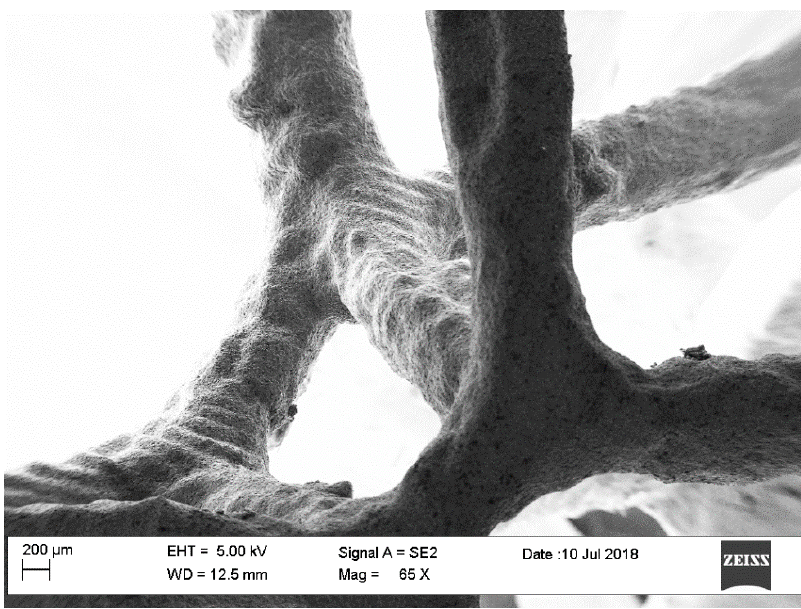
Figure 5. SEM image of 5 PPI designed metal foam.